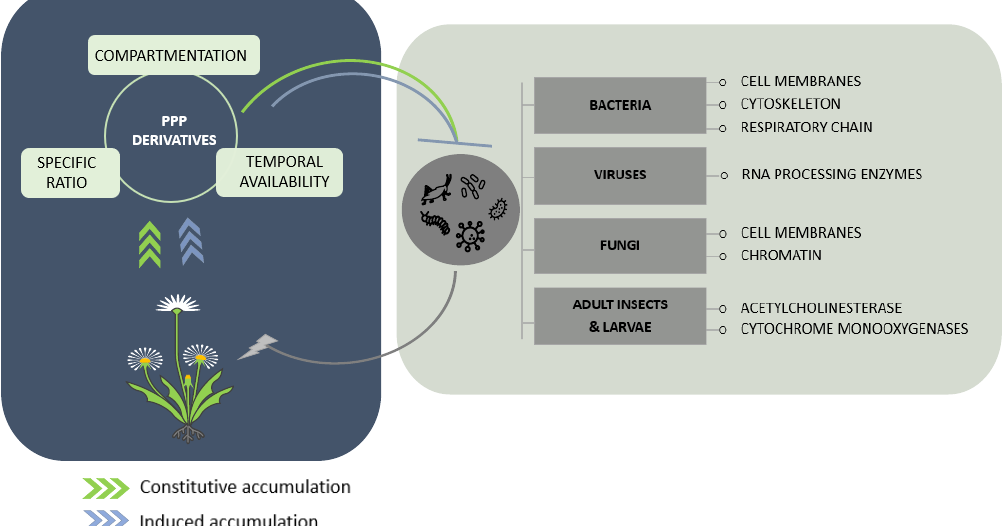
Figure 2. Potential intracellular targets of flavonoids and phenylpropanoids in microorganisms and insects aggressing plants. Biosynthetic accumulation can be constitutive and/or induced in response to external stimuli. The protective action of phenylpropanoids and flavonoids is described as the combinatory effect of their localization during the host’s interaction with aggressors, their sustained availability, and the promotion of specific compounds over others among the same subfamily or their putative synergy. Their action on microorganisms and insects probably arises from interference with important cellular machineries and structures, but this is not fully understood for all types of pests and pathogens.